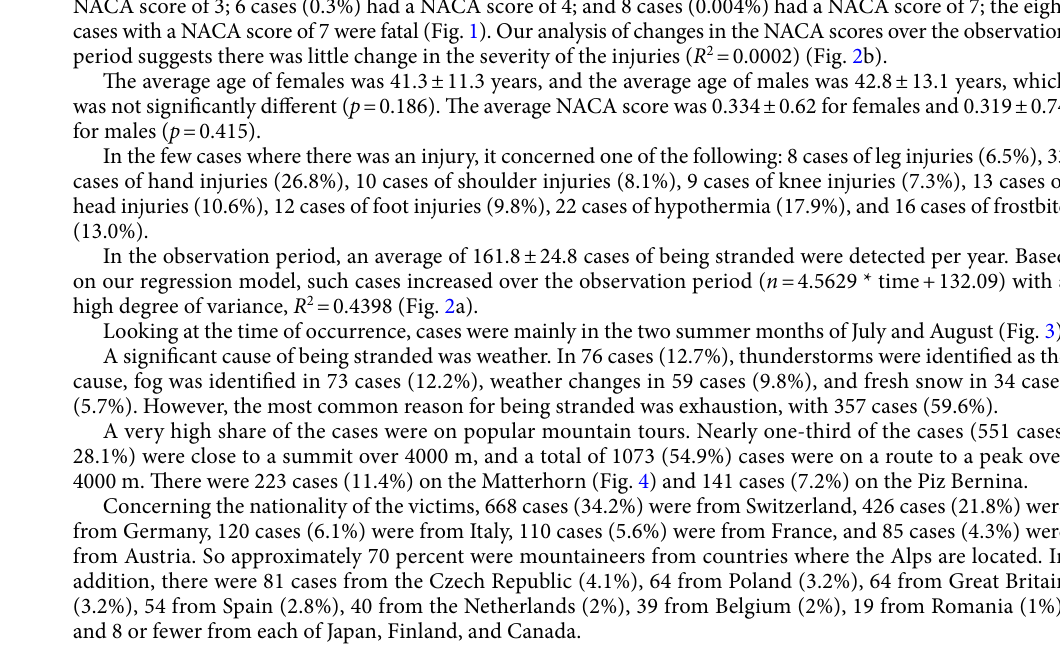
of 0; 296 cases had a NACA score of 1 (15.2%); 83 cases (4.2%) had a NACA score of 2; 27 cases (1.3%) had a NACA score of 3; 6 cases (0.3%) had a NACA score of 4; and 8 cases (0.004%) had a NACA score of 7; the eight